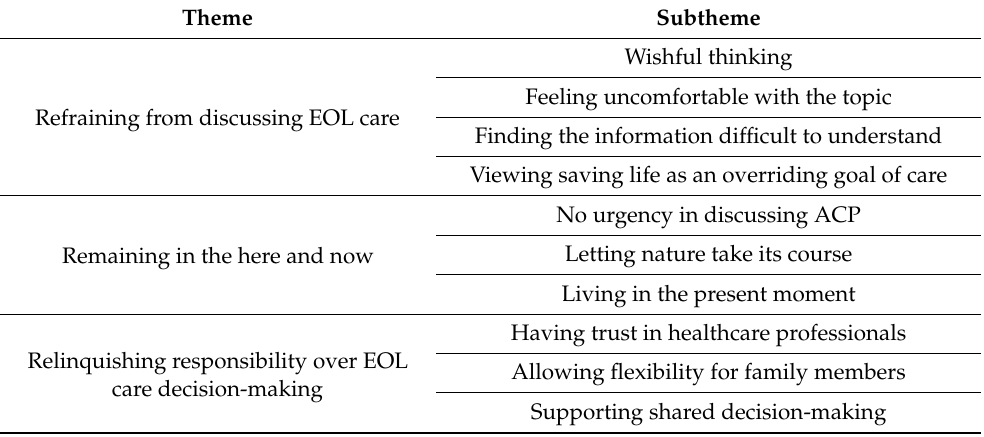
Table 2. Themes and subthemes. Theme